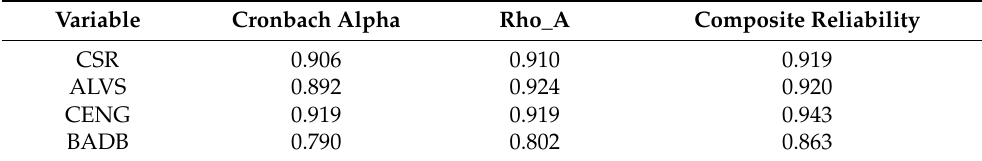
Table 4. Reliability statistics.